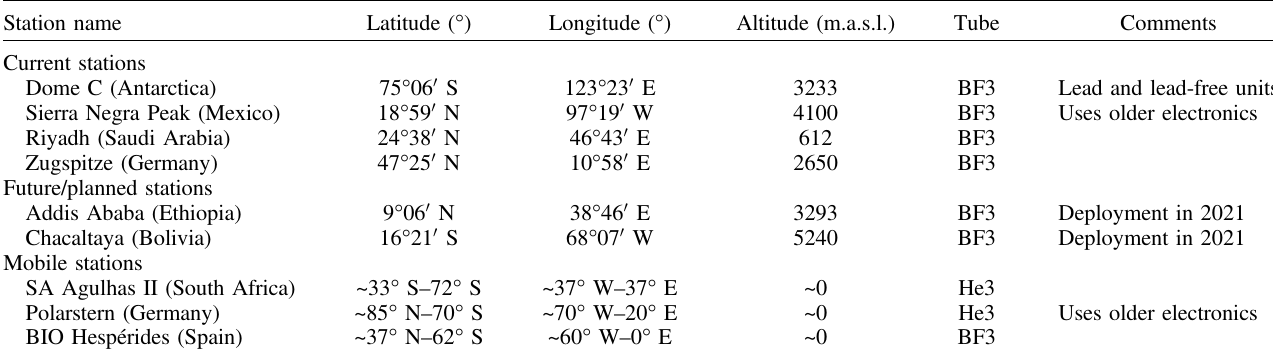
Table 2. Current and planned mini-neutron monitor stations. Station